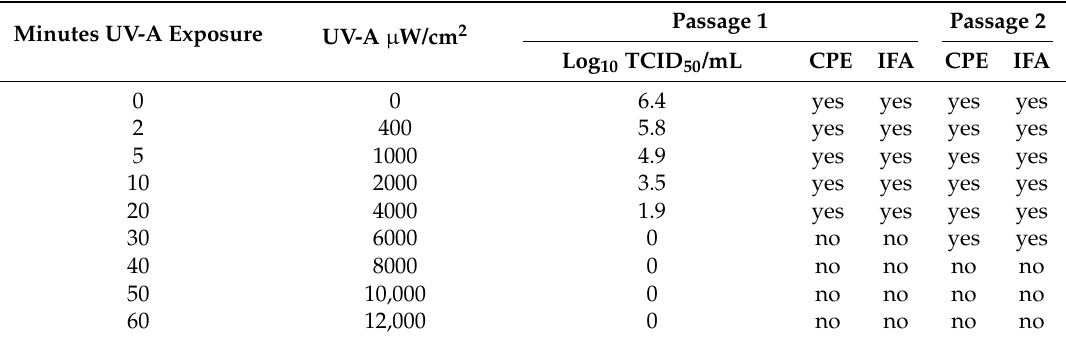
Table 3. DENV viability assessed by TCID 50 (50% tissue culture infectious dose), cytopathic effects (CPE) and IFA after inactivation with 4 1 -aminomethyl-trioxsalen (AMT) plus ultraviolet light. Minutes UV-A